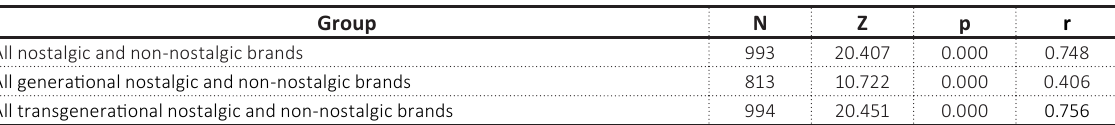
Source: Own study.